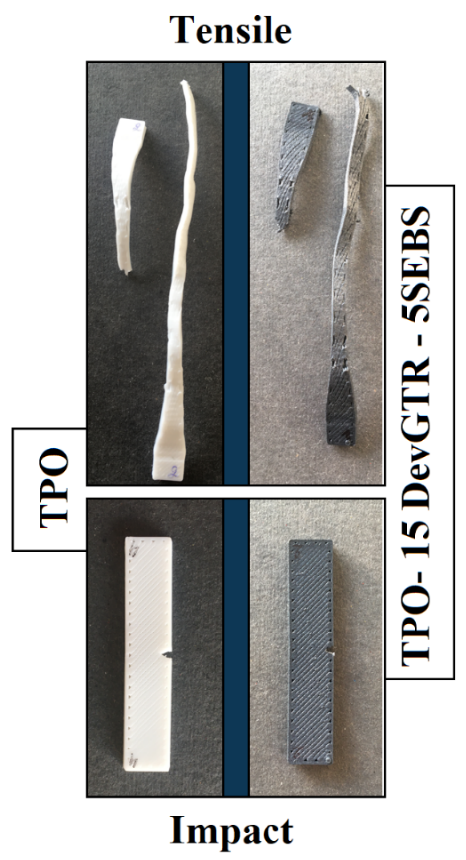
Figure 9. Images of 3D printed specimens after tensile and impact tests.